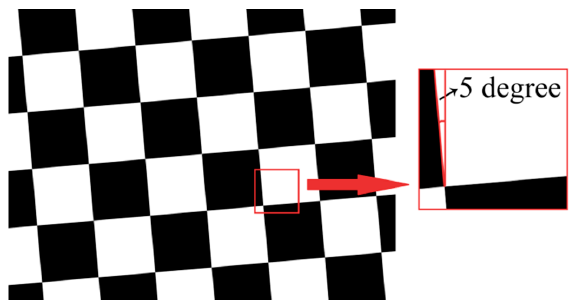
Figure 12. Structure of the target used to test the imaging quality.